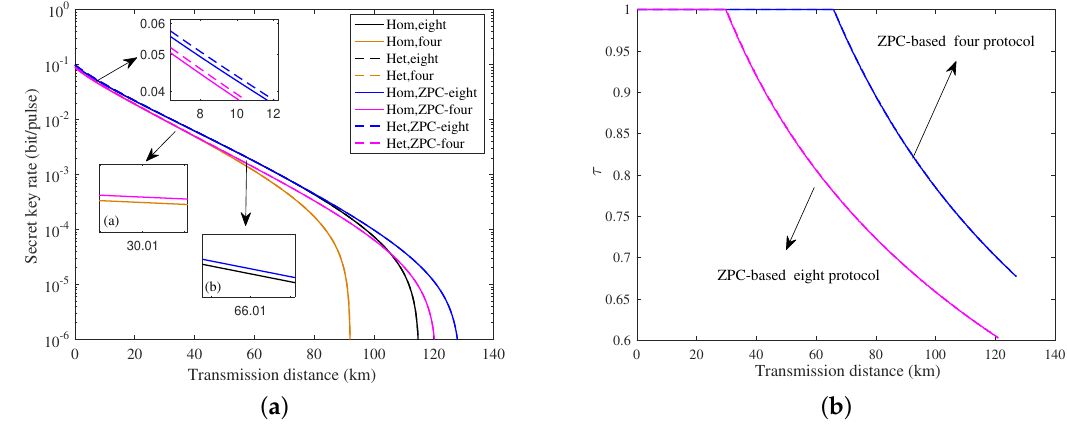
Figure 6. ( a ) Asymptotic secret key rate of DM–CVQKD involving the ZPC operation for ε = 0.01, where solid lines denote homodyne detection, while dashed lines heterodyne detection. ( b ) Corresponding to ( a ), the transmittance τ varies with the transmission